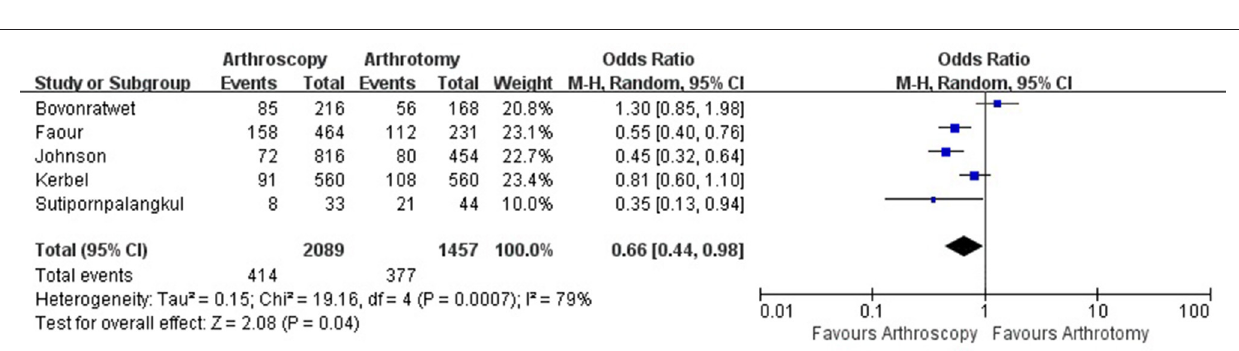
FIGURE 6 | Forest plots of the comparison of arthroscopy and arthrotomy for postoperative range of motion.